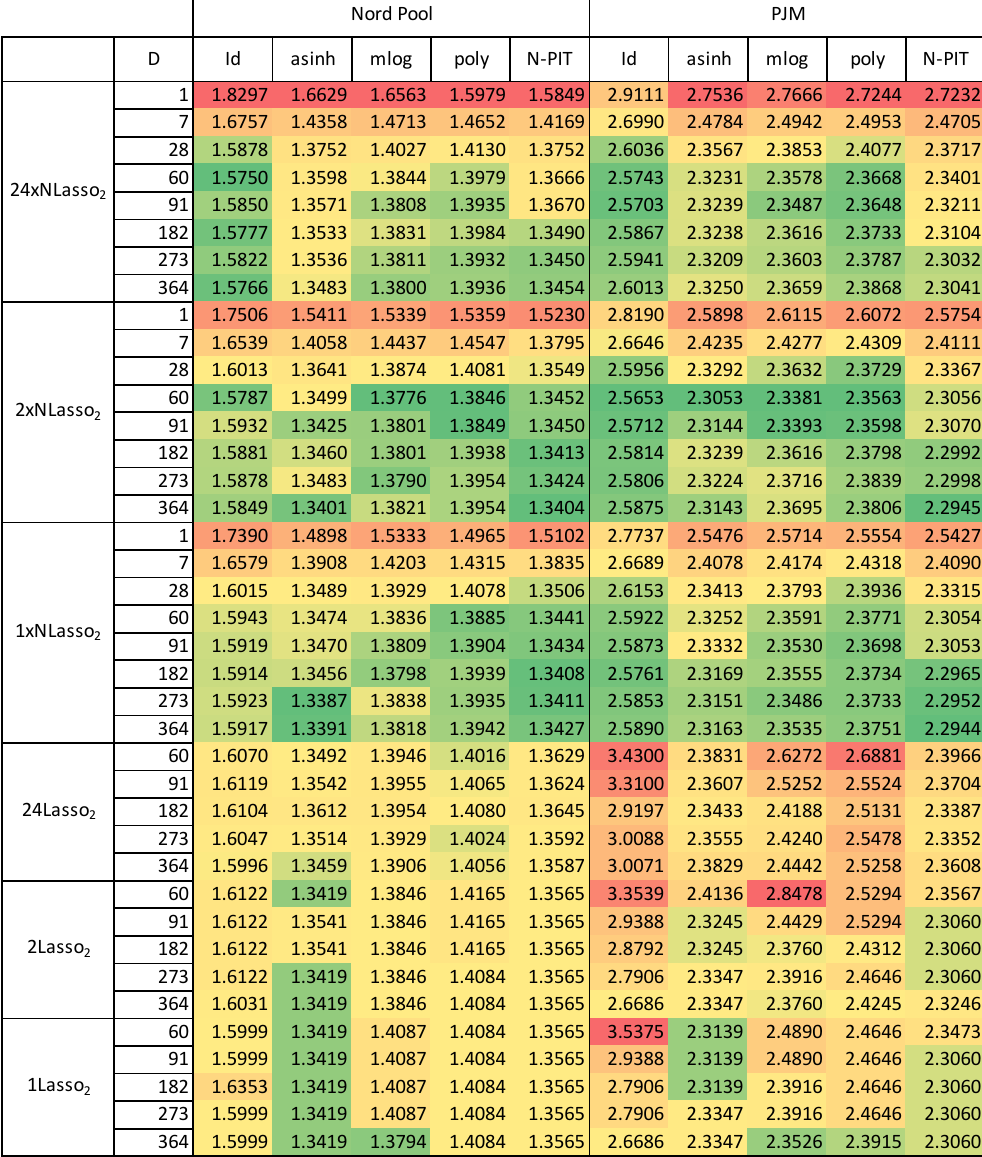
Table 2. Mean absolute errors (MAE) in the 631-day test period for 39 different λ -selection schemes (in rows), five VSTs (in columns; the first ‘transformation’ is identity, Id ) and two markets (Nord Pool and PJM). A heat map is used to indicate better ( → green) and worse ( → red) results. Note that this time, the coloring is independent for each column to better emphasize the differences between the D